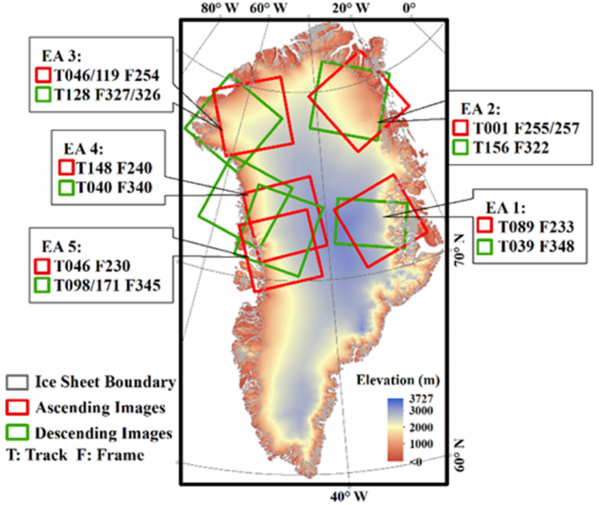
Figure 1. Five experimental areas (EAs) and Sentinel-1 image pairs coverage on